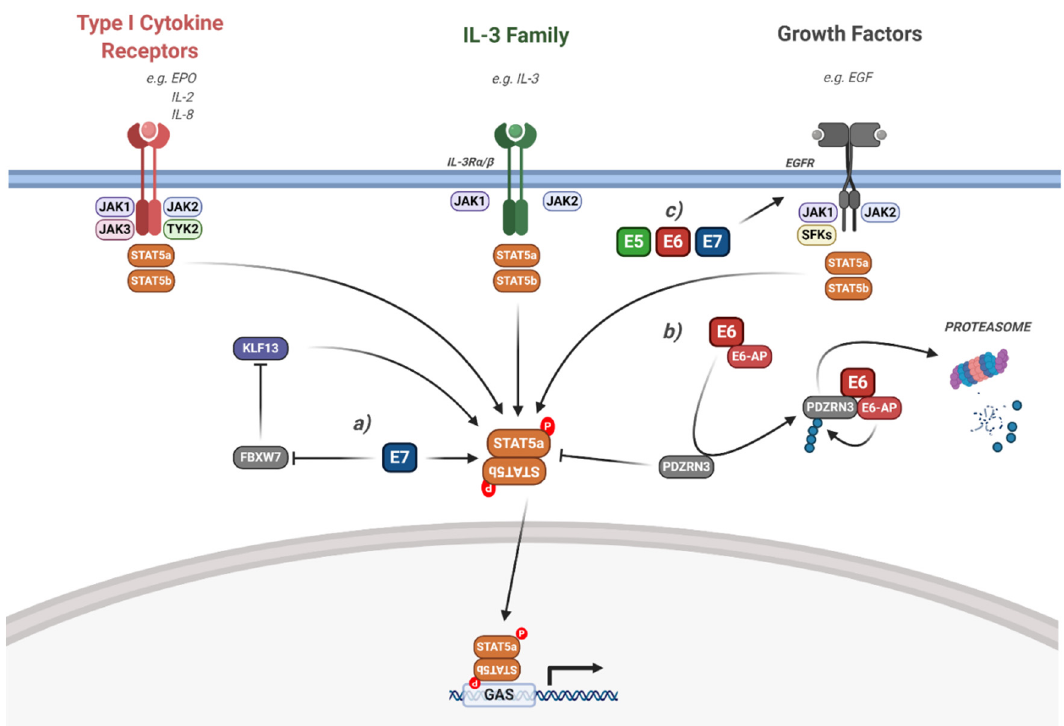
Figure 7. HPV modulation of the STAT5 signalling pathway . Diagram of STAT5 signalling. The interaction of the HPV proteins is highlighted. ( a ) HPV E7 activates STAT5 via the inhibition of FBWX7-induced KLF13 degradation. ( b ) HPV E6 induces STAT5 activation via the E6-AP mediated degradation of PDZRN3. ( c ) HPV E5, E6 and E7 can all induce EGFR signalling, which leads to downstream STAT5 activation. The effect of viral infection and the HPV genome is not included in the figure but is discussed in the text. IL, interleukin; EGF, epidermal growth factor; EGFR, EGF receptor; EPO, erythropoietin; SFKs, Src family kinases; KLF13, Kr ϋ ppel-like factor 13; FBXW7, F-box/WD repeat-containing protein 7; E6-AP, E6-associated protein; GAS, gamma interferon activation site. Figure created using BioRENDER.com.